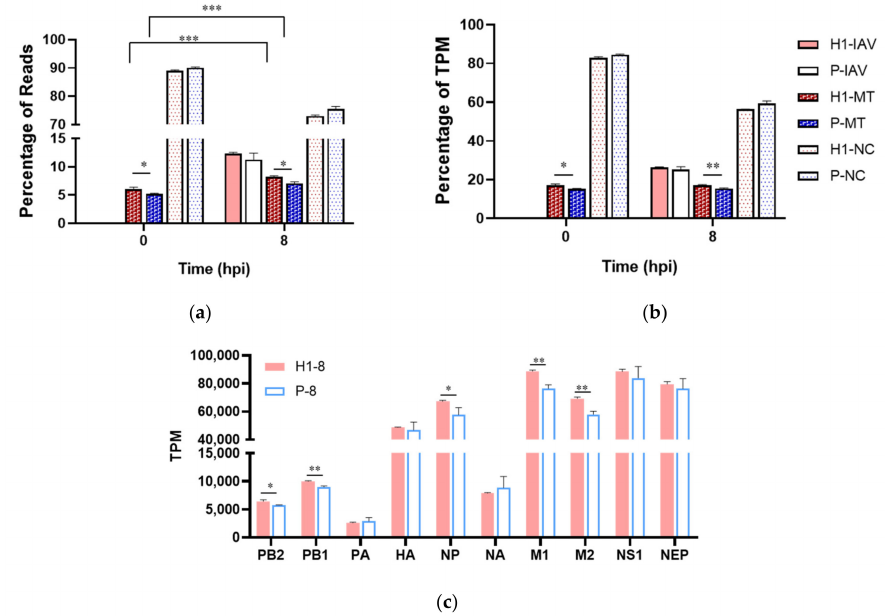
Figure 3. Enhanced expression level of five viral transcripts. ( a ) percentage of reads mapped to viral (IAV), mitochondrial (MT) and nuclear genome (NC). ( b ) percentage of total virus-coded, mitochondrion-coded, and nucleus-coded TPM. ( c ) mRNA level of IAV-coded genes at 8 hpi. Samples from triplicated infections were used for RNAseq data analysis. * p < 0.05, ** p < 0.01, *** p < 0.001. Five out of ten viral transcripts, PB2, PB1, NP, M1, and M2, were expressed at sig- nificantly higher levels in H1 than P (Figure 3c). M1 encodes matrix protein, the